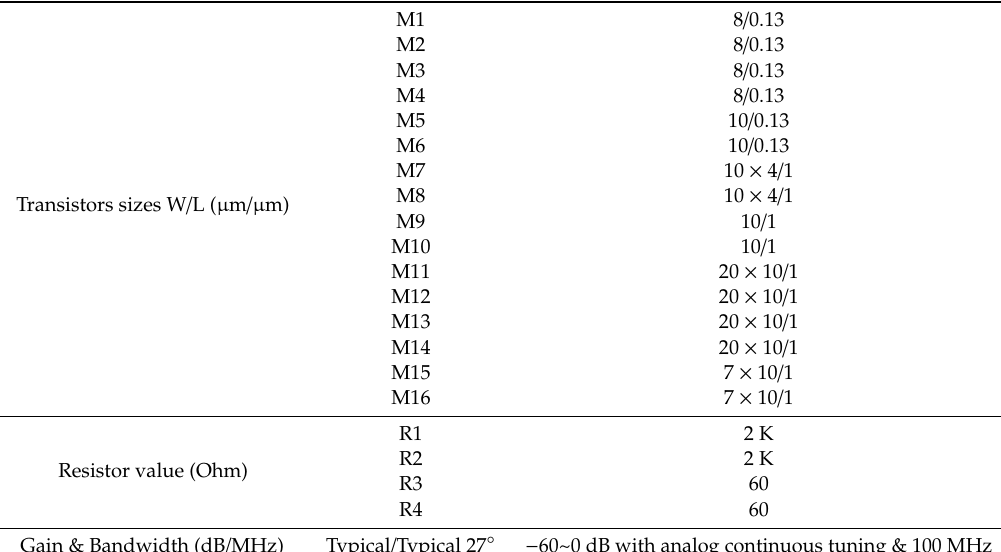
Figure 6. Variable gain amplifier (VGA) and dB-linear voltage generator schematic. Table 3. Component sizes and simulated performance specifications.